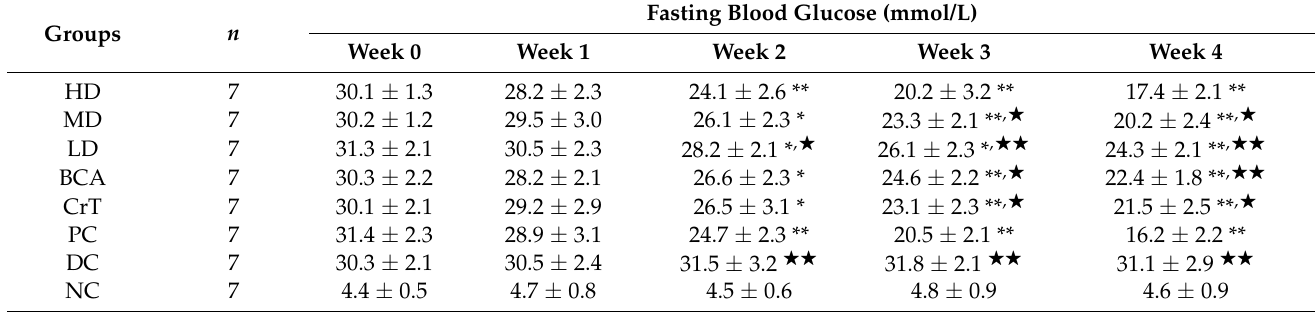
Table 3. Changes in fasting blood glucose